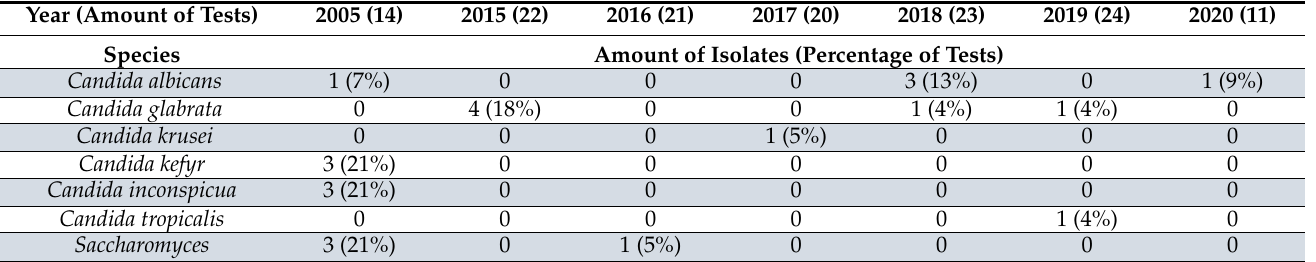
Table 3. Yeast species and Saccharomyces isolated from the lower respiratory tract in the studied